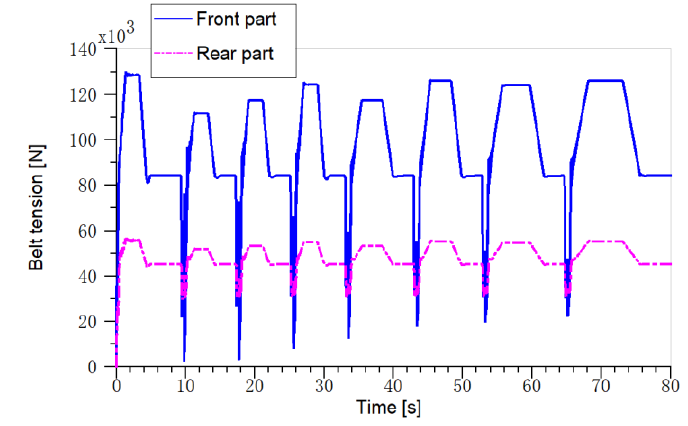
Figure 12. Belt tension curve.